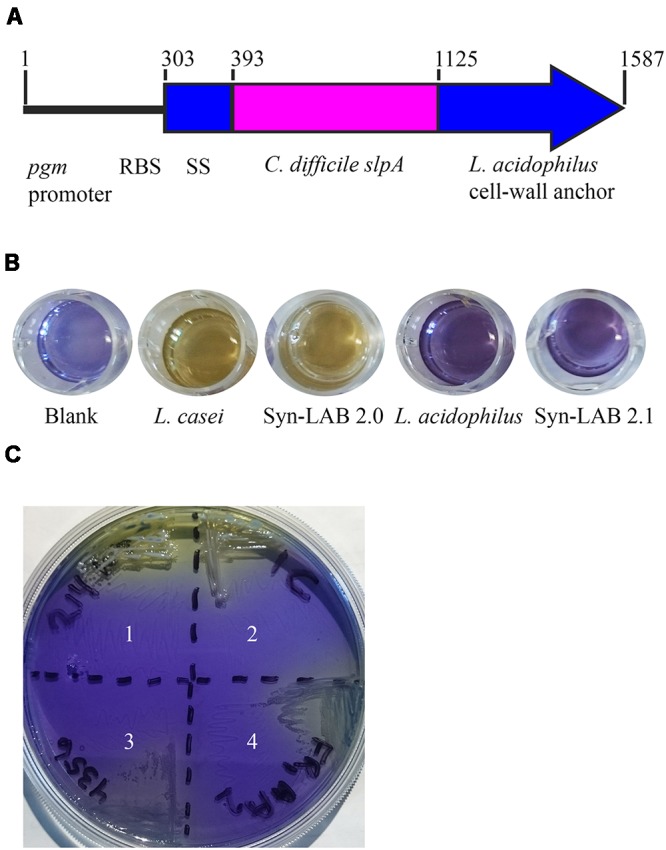
Design and confirmation of Syn-LAB strains. (A) Schematic of the slpA chimera. Expression is driven by the L. acidophilus (LA) pgm promoter and ribosome-binding site. The chimera encodes the LA signal sequence (SS), the codon-optimized C. difficile extracellular and antigenic SlpA fragment, and the LA Slp cell wall anchor. Syn-LAB strain confirmation via differential growth on mannitol-MRS broth (B) and mMRS-BPB agar (C). 1, L. casei parent strain; 2, Syn-LAB 2.0; 3, L. acidophilus parent strain; 4, Syn-LAB 2.1.